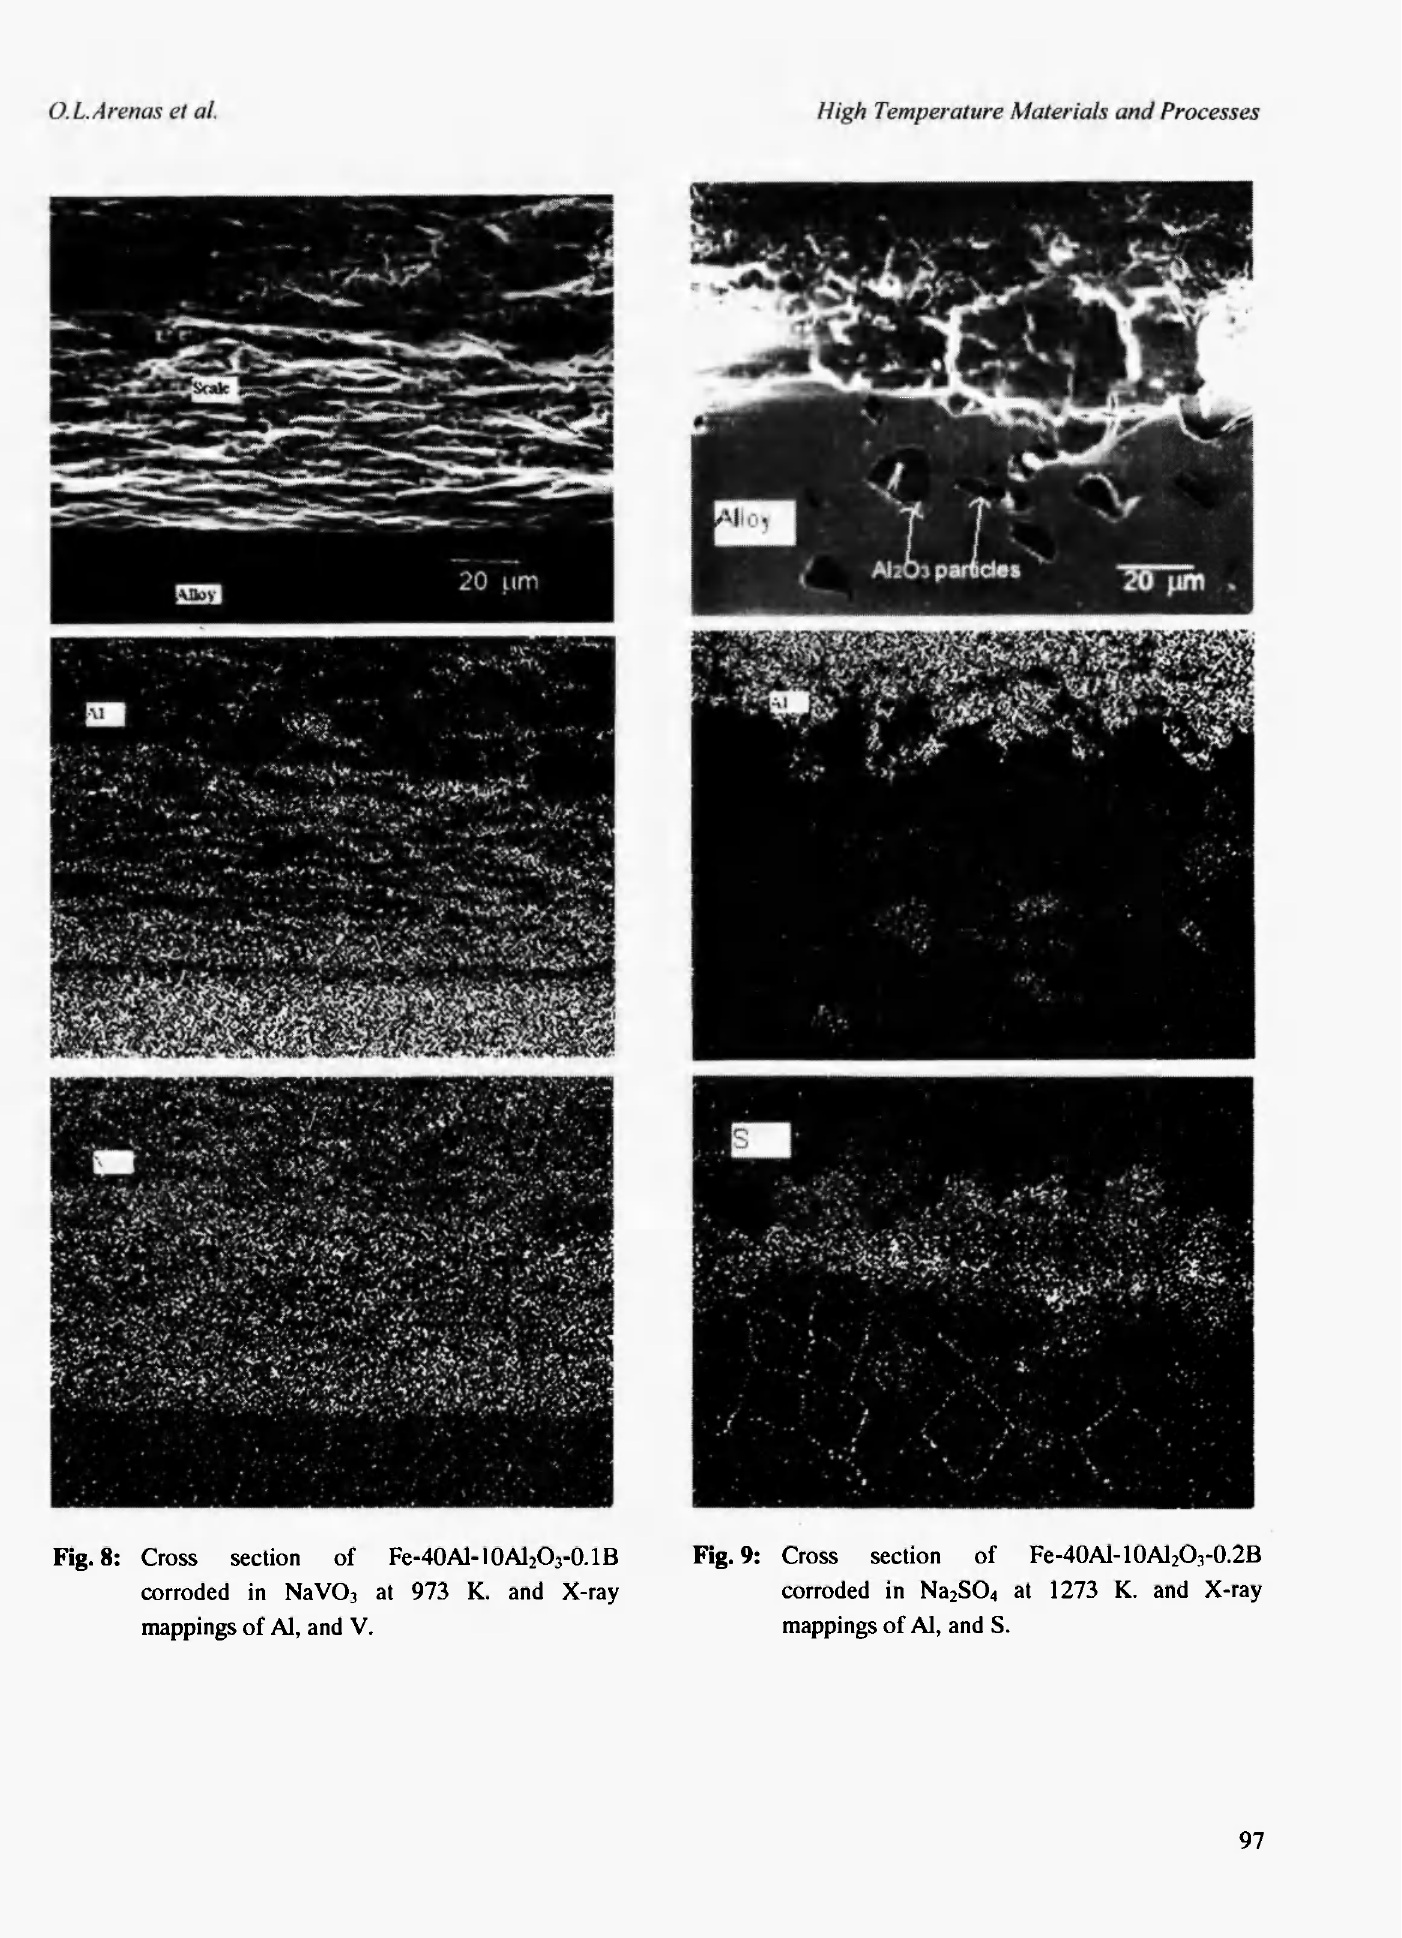
Fig. 8: Cross section of Fe-40A1-10A1 2 0 3 -0.1B Fig. 9: Cross section of Fe-40Al-10Al 2 C) r 0.2B corroded in NaV0 3 at 973 K. and X-ray corroded in Na 2 S0 4 at 1273 K. and X-ray mappings of Al, and V. mappings of Al, and S.